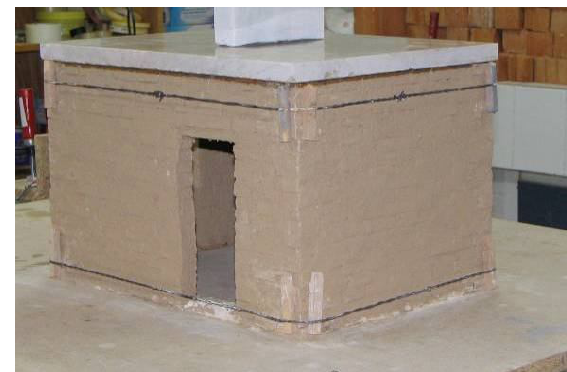
Fig. 24. Specimen P2 and horizontal post tensioning application.